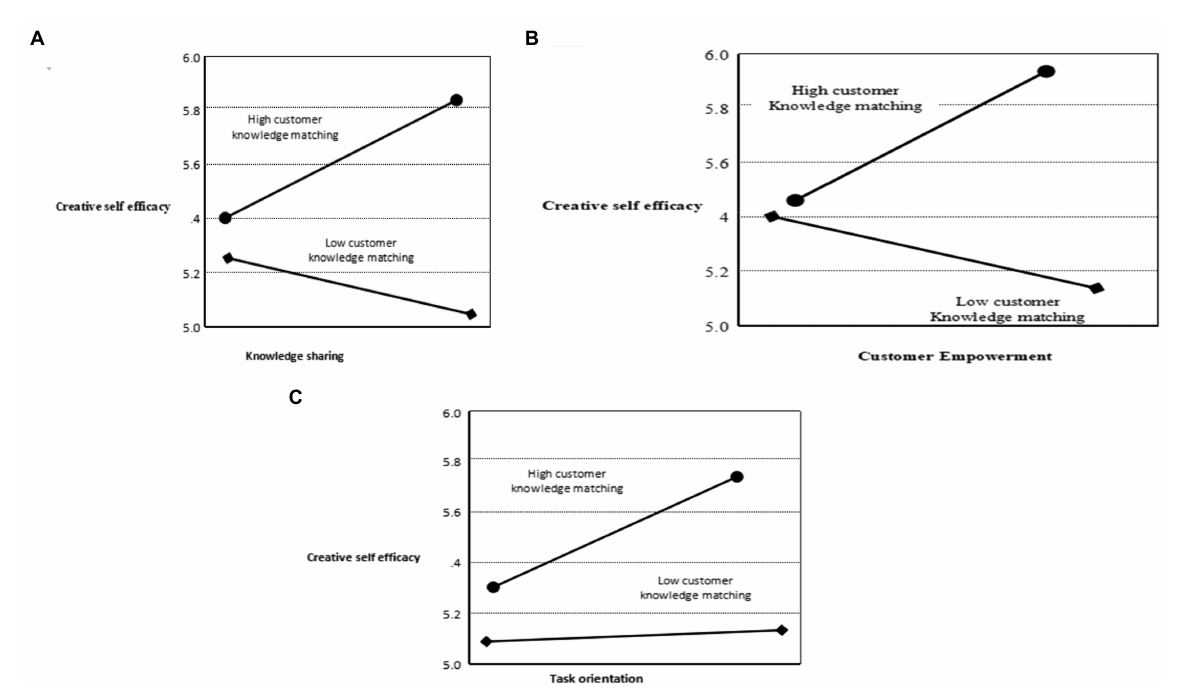
FIGURE 4 The mediating effect of customer knowledge matching. (A) The moderating effect of customer knowledge matching on the relationship between knowledge sharing and creative self-efficacy. (B) The moderating effect of customer knowledge matching on the relationship between virtual empowerment and customer creativity. (C) The moderating effect of customer knowledge matching on the relationship between task orientation and customer creativity.